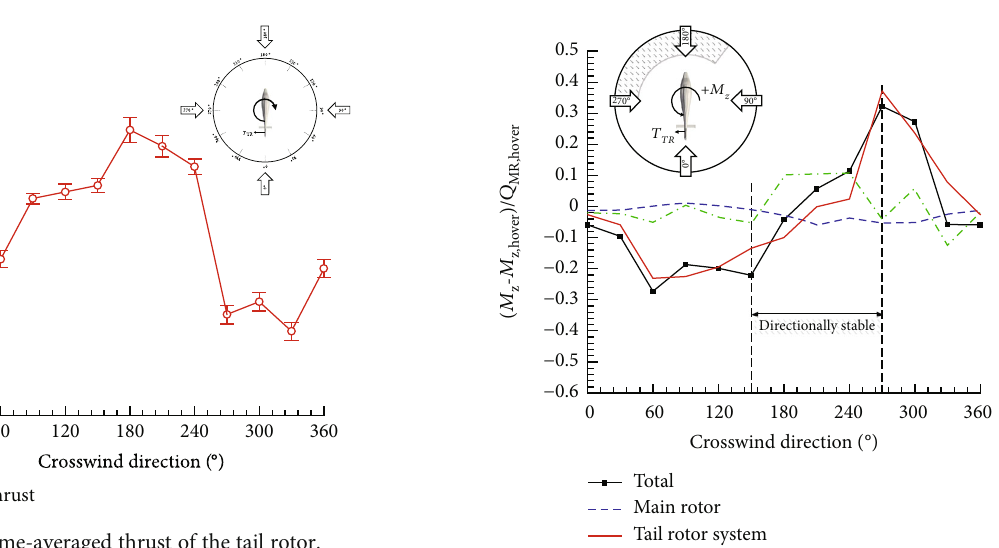
Figure 17: Time-averaged thrust of the tail rotor.